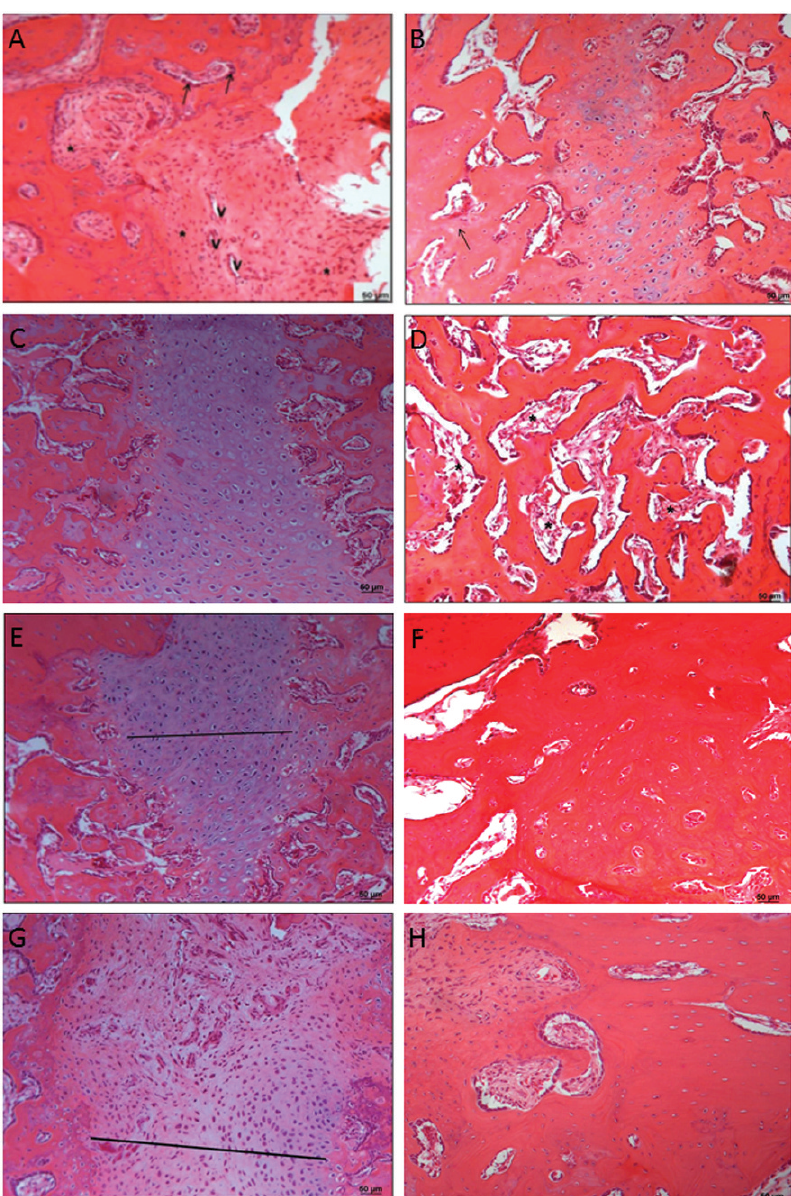
Figure 2 - A) Photomicrograph of rabbit fibula of the CG showing the region of the lesion after 2 weeks. Note that there are many connective tissue cells (*), blood vessels (V), and osteoblasts (arrows) (HE). B) Photomicrographs of the rabbit fibulae of the CG 6 weeks after the injury. Note the cartilaginous tissue and small regions of cartilage calcified into newly formed bone within the tissue (arrows) (HE). C) Photomicrograph of rabbit fibulae of the APCG 2 weeks after the injury (HE). D) Photomicrographs of the rabbit fibulae of the ACPG after 6 weeks showing the damaged areas. Note that the bone tissue contains numerous cavities (*) (HE). E) Photomicrographs of the rabbit fibulae of the HBOG showing the region of the lesions after 2 weeks. Note the cartilaginous tissue (straight line) (HE). F) Photomicrographs of the rabbit fibulae of the HBOG showing the region of the lesion after 6 weeks (HE). G) Photomicrographs of the rabbit fibulae of the APC + HBOG after 2 weeks showing the region of the injury. Note that the site of the injury is filled with cartilage tissue (straight line) (HE). H) Photomicrographs of the rabbit fibulae of the APC + HBOG after 6 weeks showing the region of the injuries. Notethe absenceofinjury andthe bonetissue that formed(HE). HBOGwassuperior totheAPCG acrossall periods